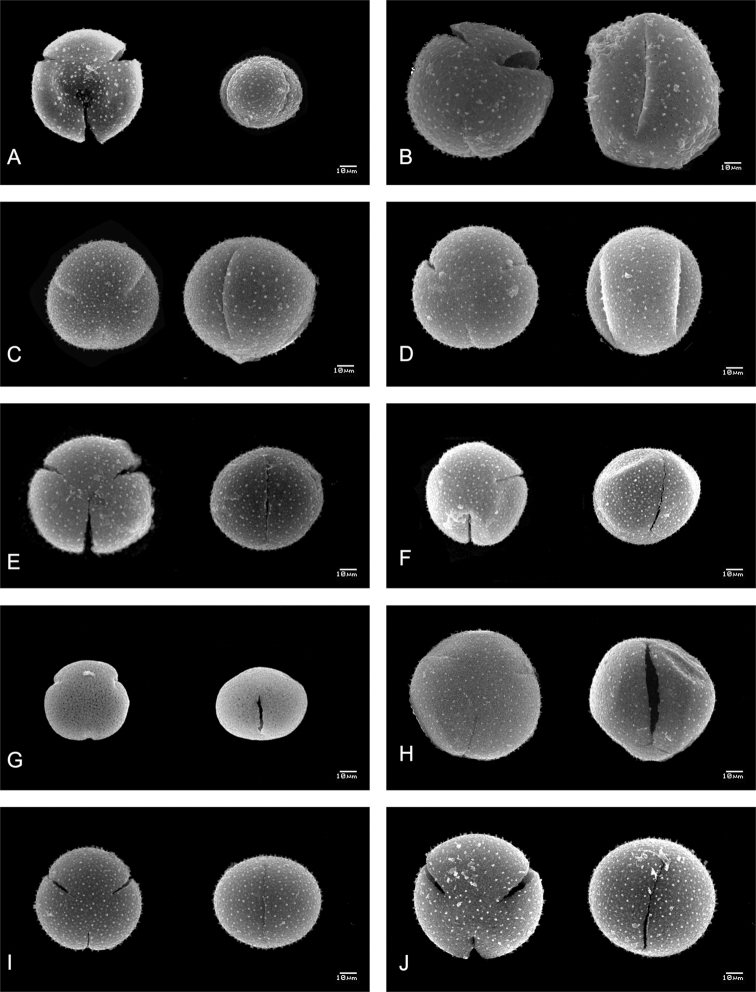
Pollen grains of tribe Hylocereeae (Scanning Electron Microscope photographs). Left polar view, right equatorial view AAcanthocereus
tetragonus (C. Ruiz et al. 576) BDisocactus
ackermanii (R. Torres et al. 309) CEpiphyllum
oxypetalum (C. Ruiz et al. 640) DSelenicereus
costaricensis (C. Ruiz et al. 555) ES.
escuintlensis (C. Ruiz et al. 635) FS.
guatemalensis (M. Véliz et al. 20227) GS.
minutiflorus (C. Ruiz et al. 627) HS.
ocamponis (M. Cházaro 7334) IS.
polyrhizus (C. Ruiz et al. 566) JS. sp. (C. Ruiz et al. 608).